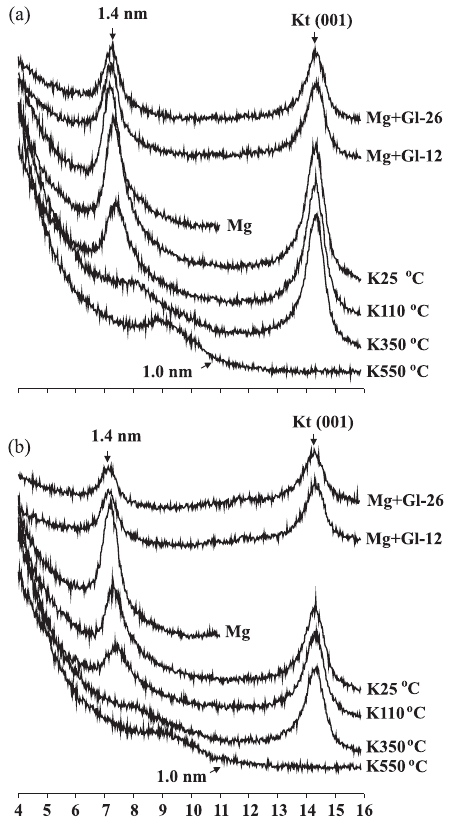
Figure 2. X-ray diffractograms of the clay fraction of soil under conventional tillage (a) and no- tillage (b) after treatment with sodium citrate. Mg: saturation by magnesium; Mg + Gl-n o - saturation by magnesium followed by solvation with glycerol for 12 and 26 days; Kn o o C: saturation by potassium and respective thermal treatments; Kt: kaolinite. Scale in degrees ( o 2 ΘΘΘΘΘ ).